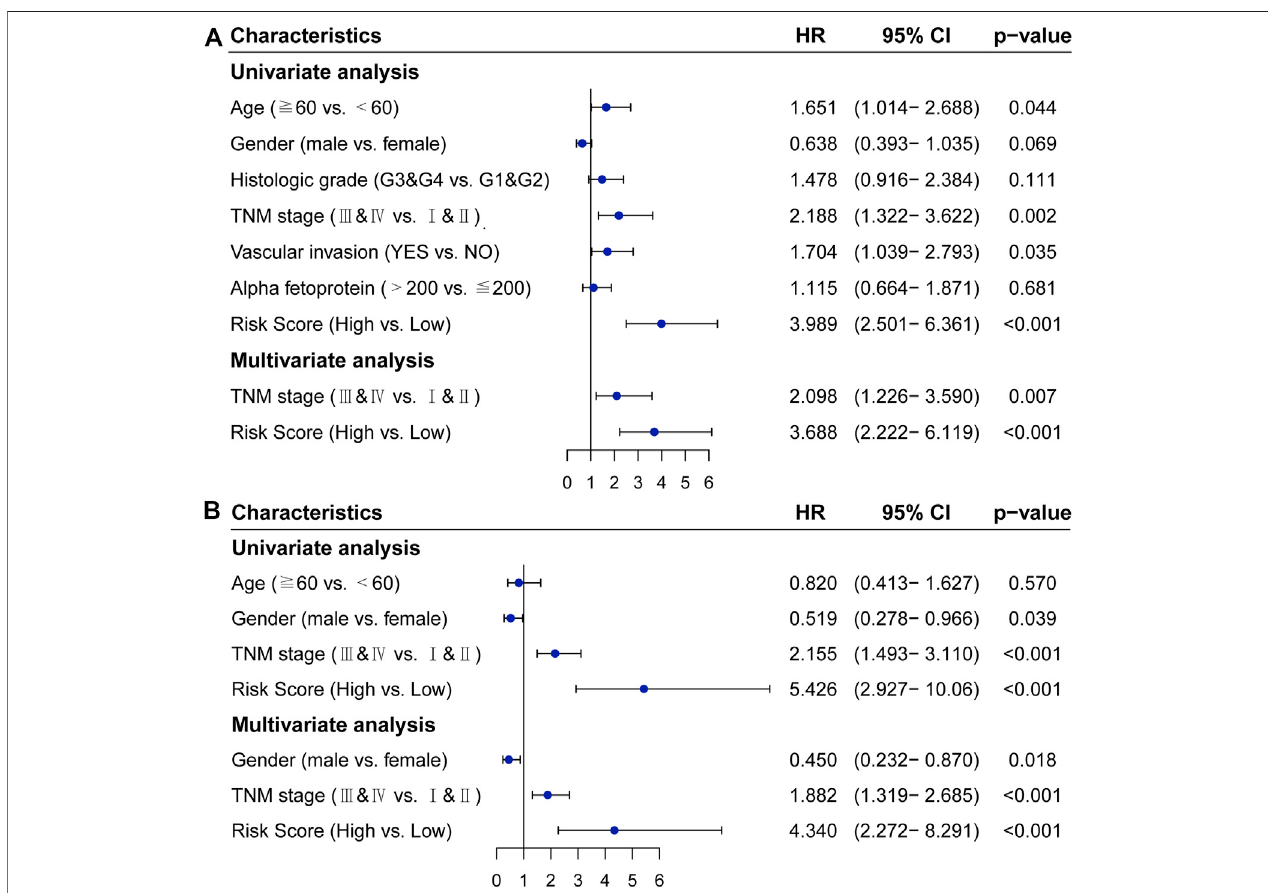
FIGURE 3 | Cox proportional hazards regression model analysis of overall survival in patients with hepatocellular carcinoma. (A) TCGA cohort. (B) ICGC cohort. HR: hazard ratio, CI: con fi dence interval.